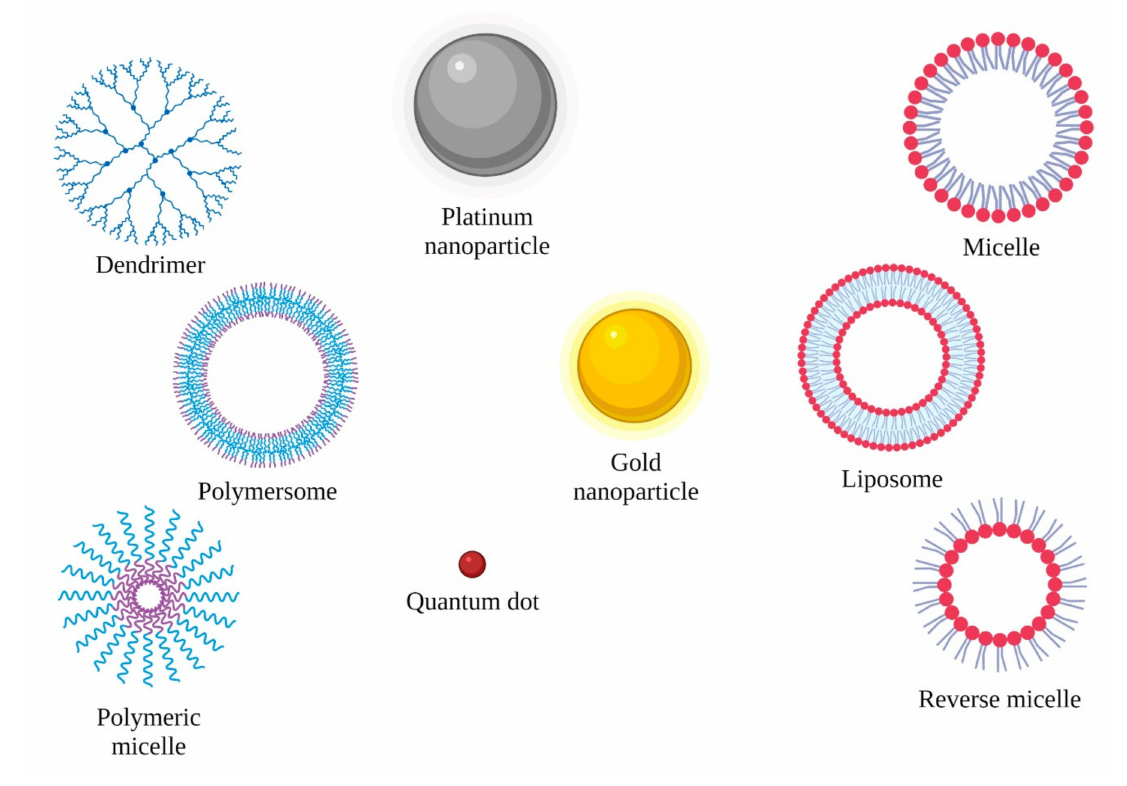
Figure 1. Types of nanoparticles (created using BioRender.com, access date: 6 May